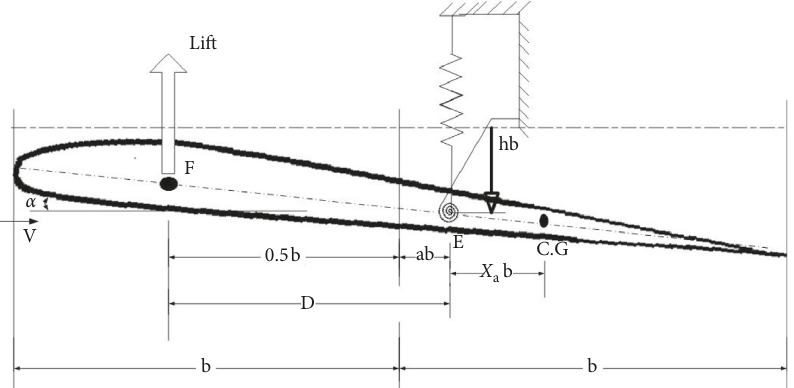
Figure 1: Two-degree-of-freedom airfoil